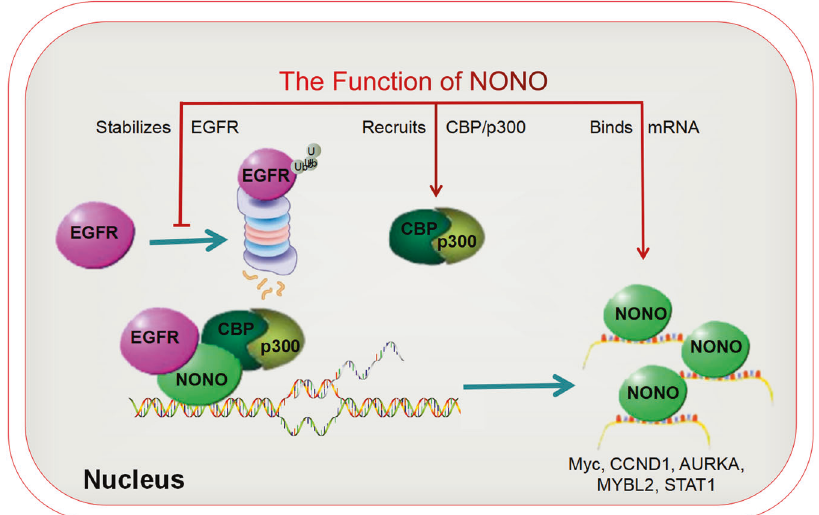
Fig. 8 Schematic illustration of mechanisms of NONO in nuclear EGFR-mediated malignant progression of TNBC. On the one hand, NONO enhanced the transcription activity of nuclear EGFR by stabilizing its protein and recruiting the transcriptional co-activator CBP/p300. On the other hand, NONO bound subsequent mRNAs to enhance their stability, including Myc, CCND1, AURKA, and so on. What ’ s more, nuclear EGFR could enhance the af fi nity of NONO to